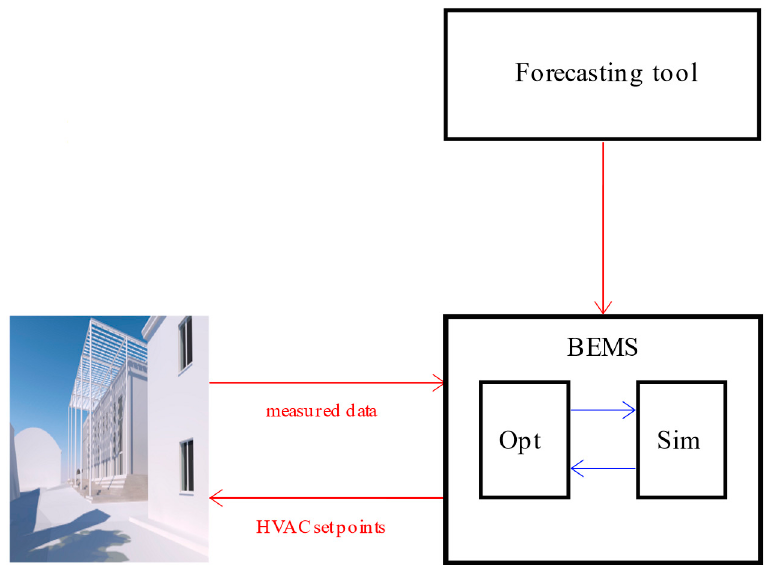
Figure 1. The proposed Building Energy Management System (BEMS) architecture.